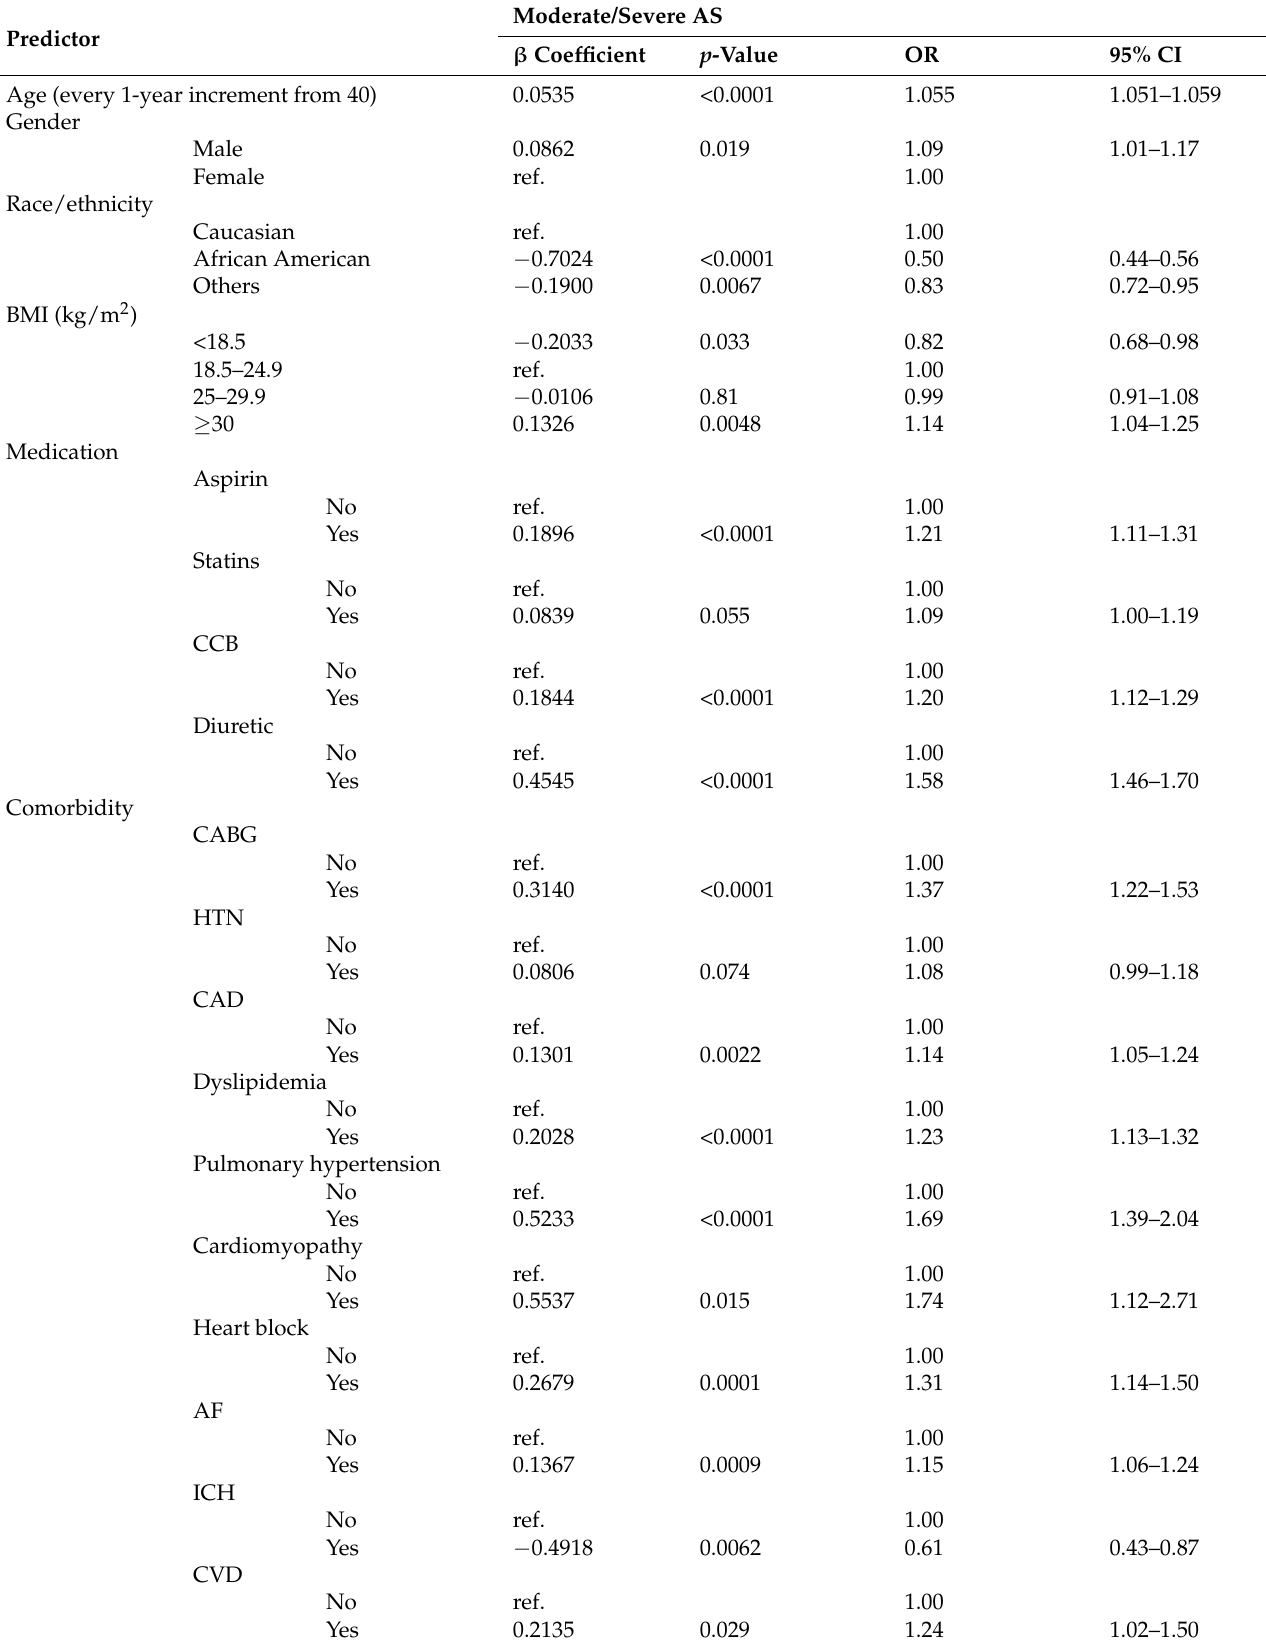
Table 2. Logistic regression coefficients and ORs for advanced